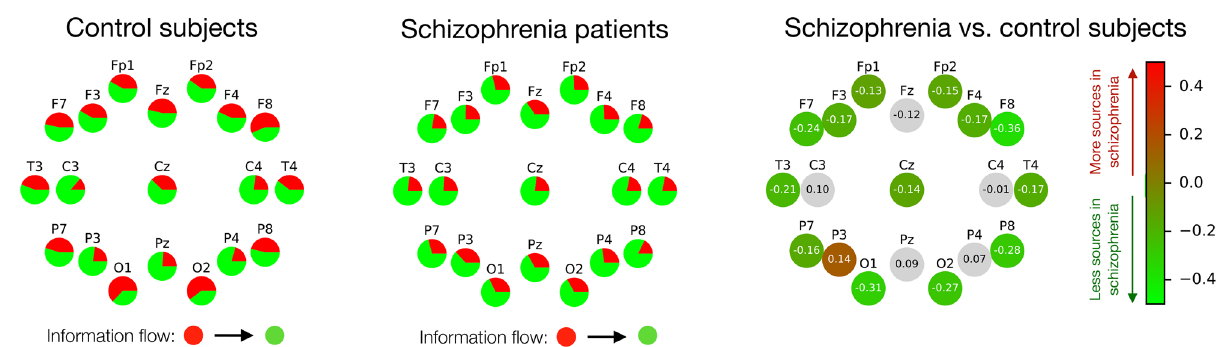
Figure 5. Improved sensitivity due to merging. The three panels report, for N = 4 , 8 and 12, and as a function of the coupling γ : the average error of the best clustering, compared with the real cluster assignation (black solid lines); and the fraction of times the Granger causality test fails to detect a statistically significant result between all elements of the first cluster and those of the second (green dashed lines).